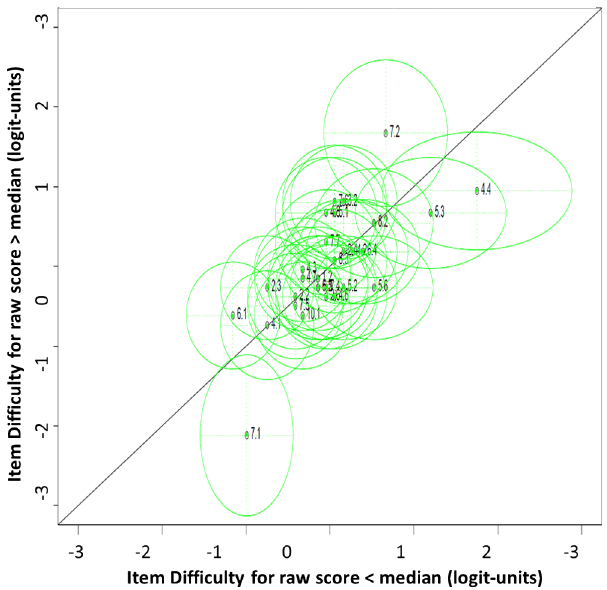
FIG. 5. Likelihood ratio goodness-of-fit with median-split criterion for PSCI-ALPHA. In order to check the invariance of the Rasch scale, the item parameters are plotted for two subgroups of the sample in field testing. The item parameters estimated from the answer patterns of 41 persons with raw scores lower than median are plotted on the horizontal axis. The item parameters estimated for 41 persons with scores higher than the median are plotted on the vertical axis. The two 95% confidence intervals of each double-estimated parameter give an ellipse. The items invariant to sample split fall on or close to the bisector of slope 1 shown as a solid black line. The items situated farthest from the bisector have the poorest